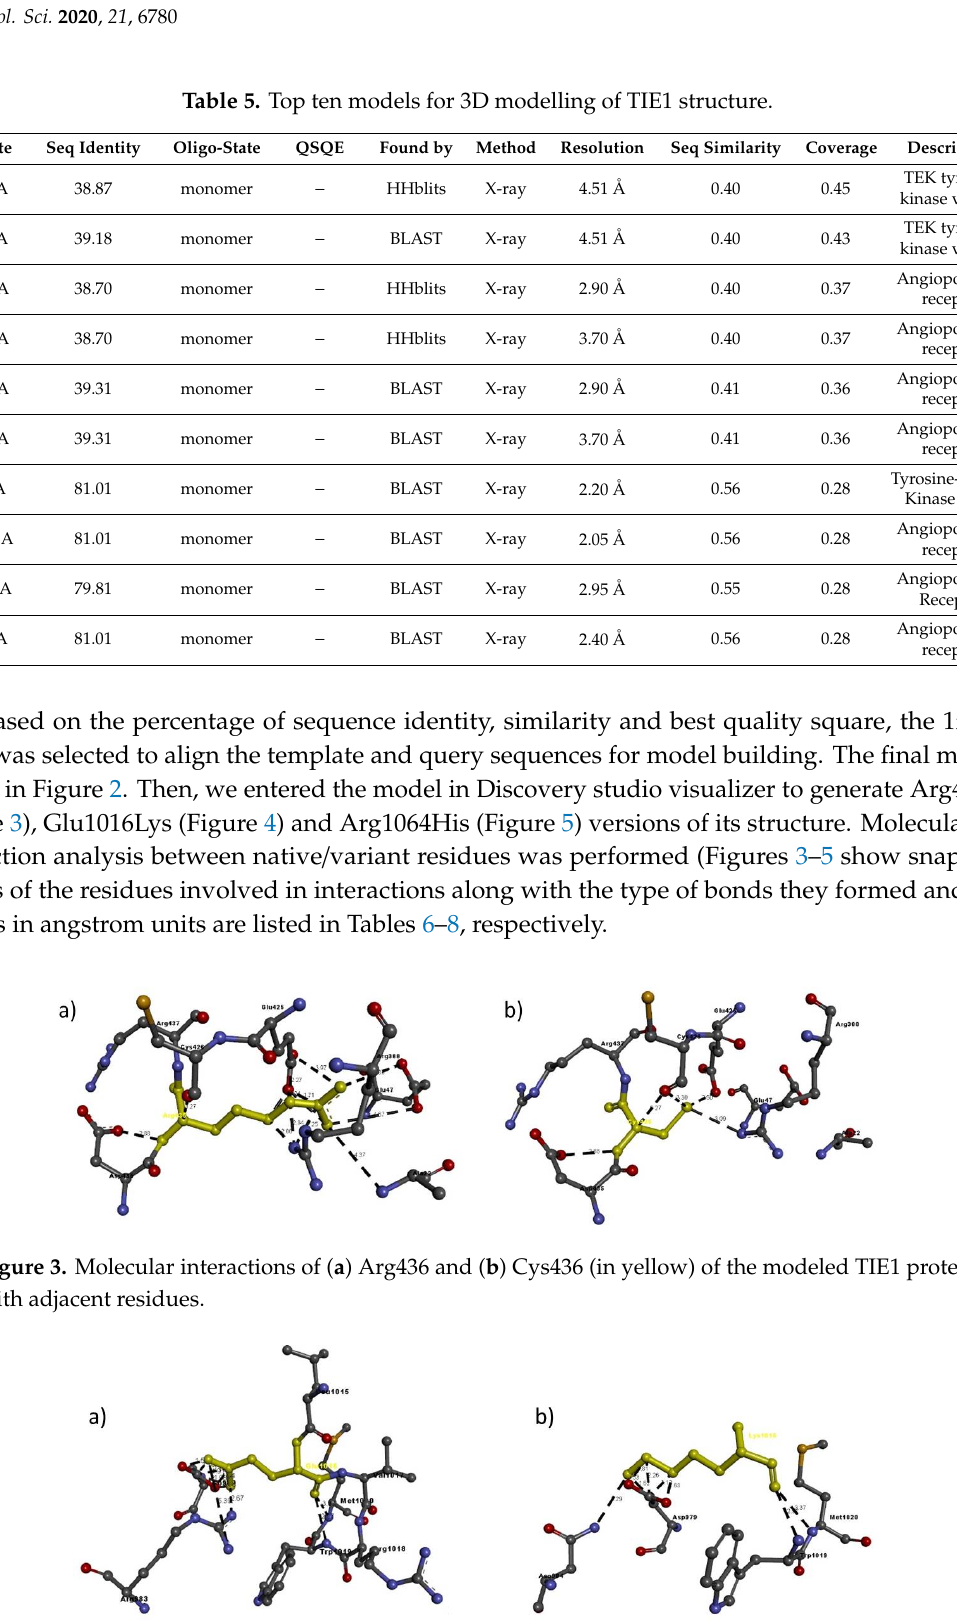
Table 5. Top ten models for 3D modelling of TIE1 structure.